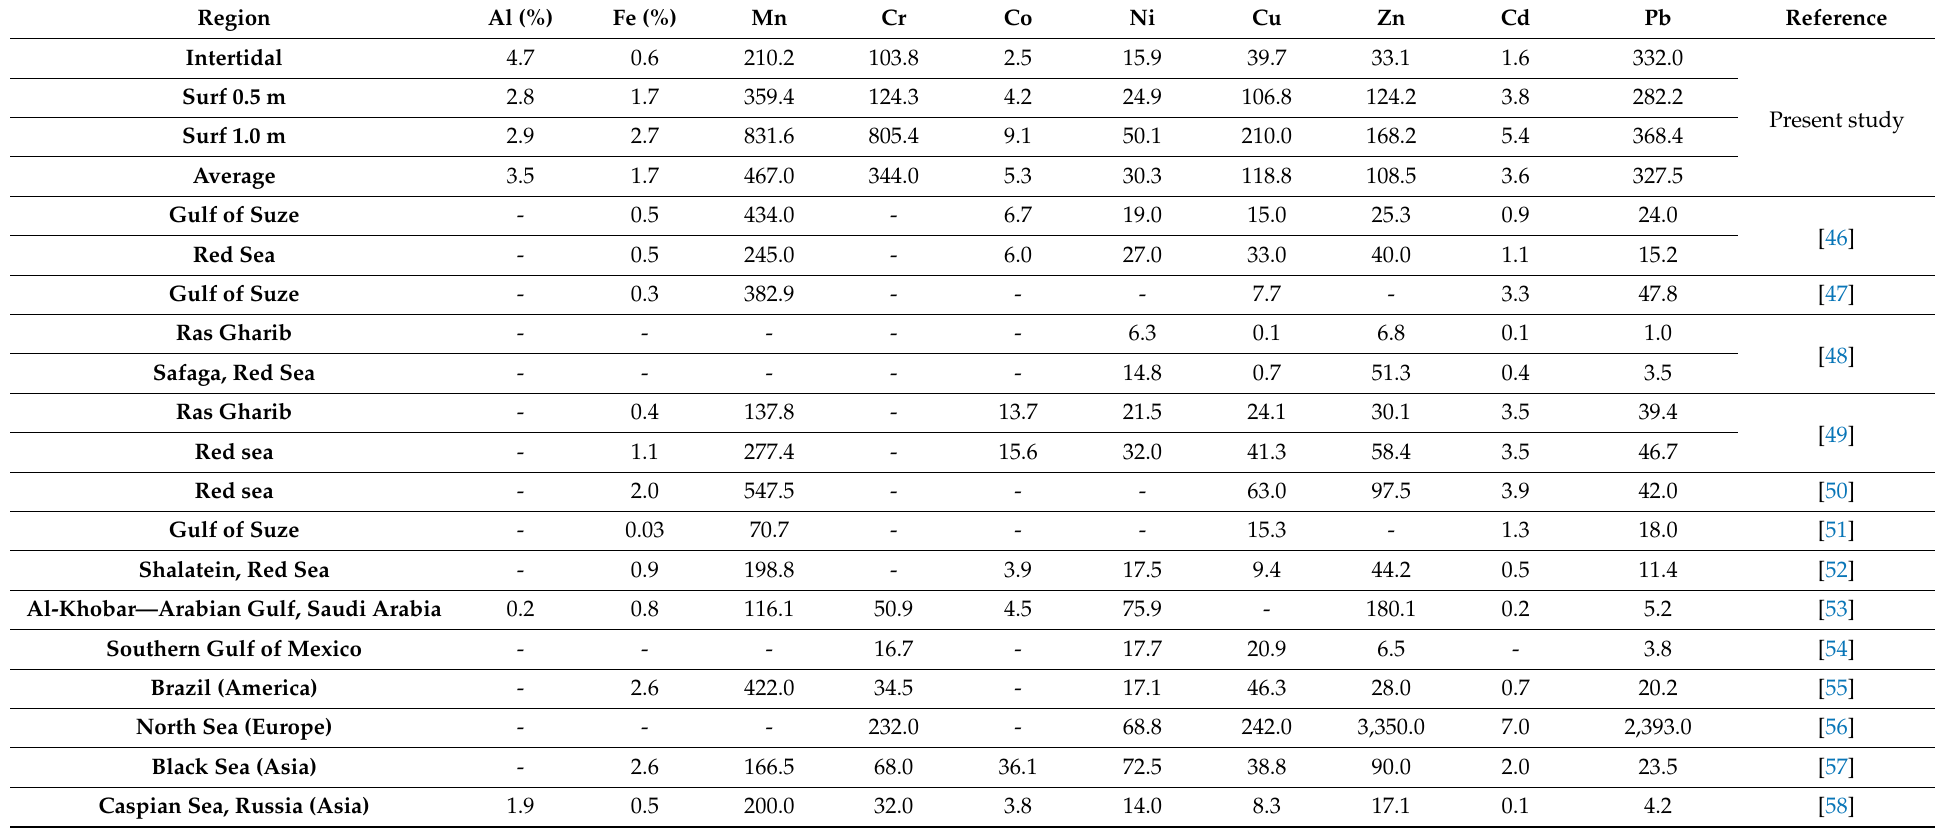
Table 7. Comparison of heavy metal averages in surface sediment of the present study and other coastal areas with presence of the petroleum industry. Region Reference Intertidal